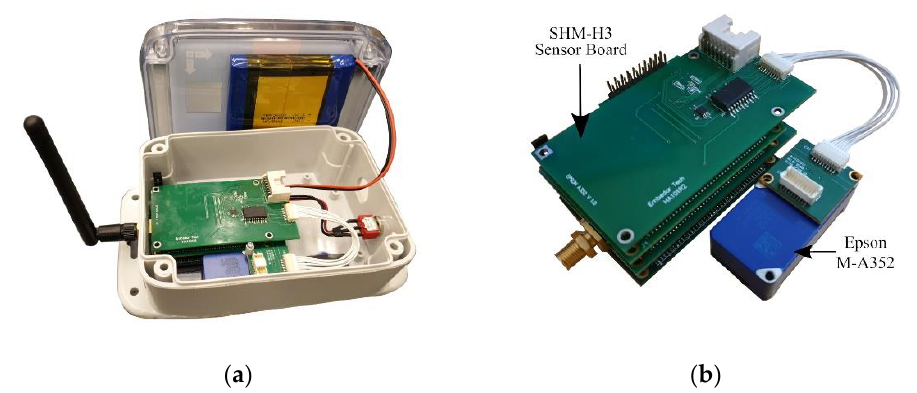
Figure 1. Xnode: ( a ) Xnode and enclosure with M-A352 accelerometer ( b ) Designed sensor board for M-A352.